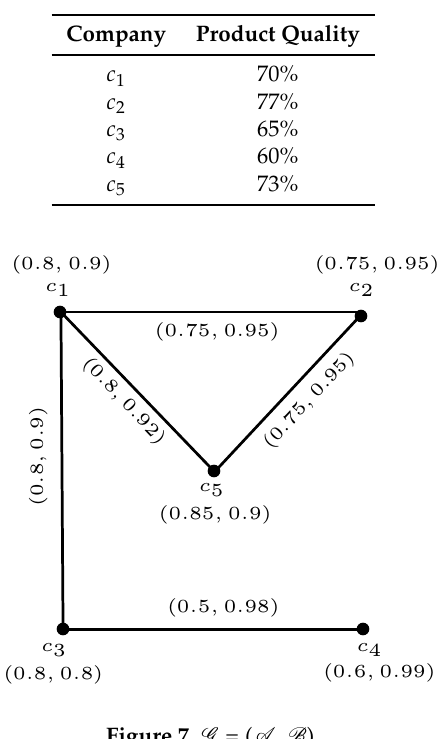
Table 1. Quality of Products.